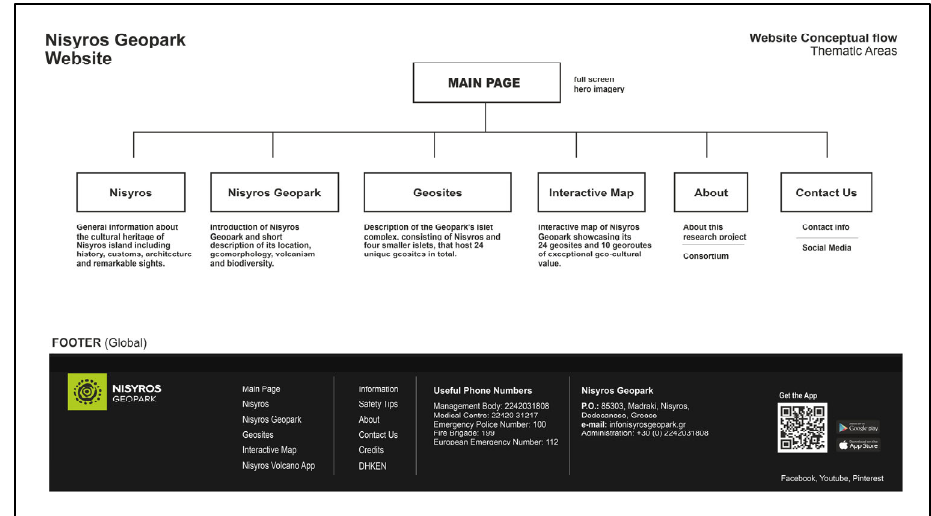
Figure 7. Conceptual flow of the official Nisyros Geopark website, showing the site’s available thematic areas.